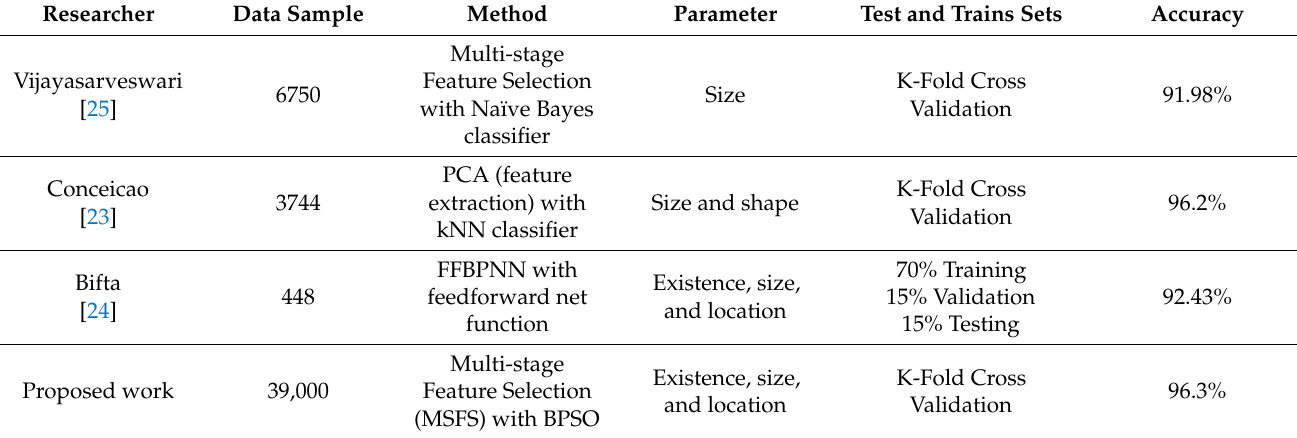
Table 7. Comparison results with the previous